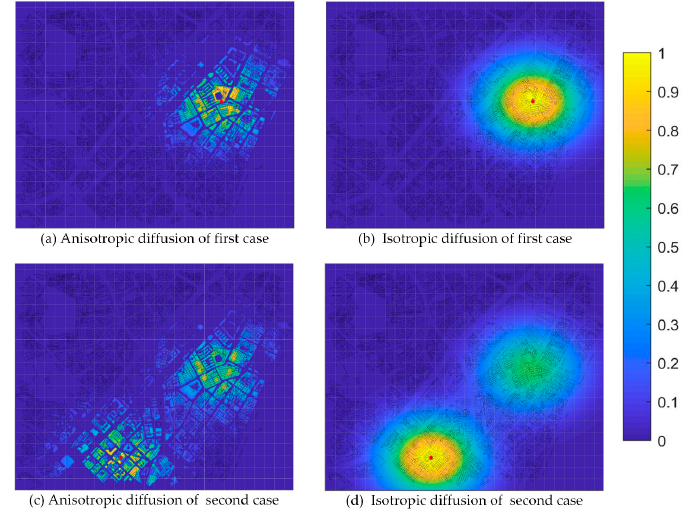
Figure 6. Anisotropic and isotropic diffusion of crime risk in study area.